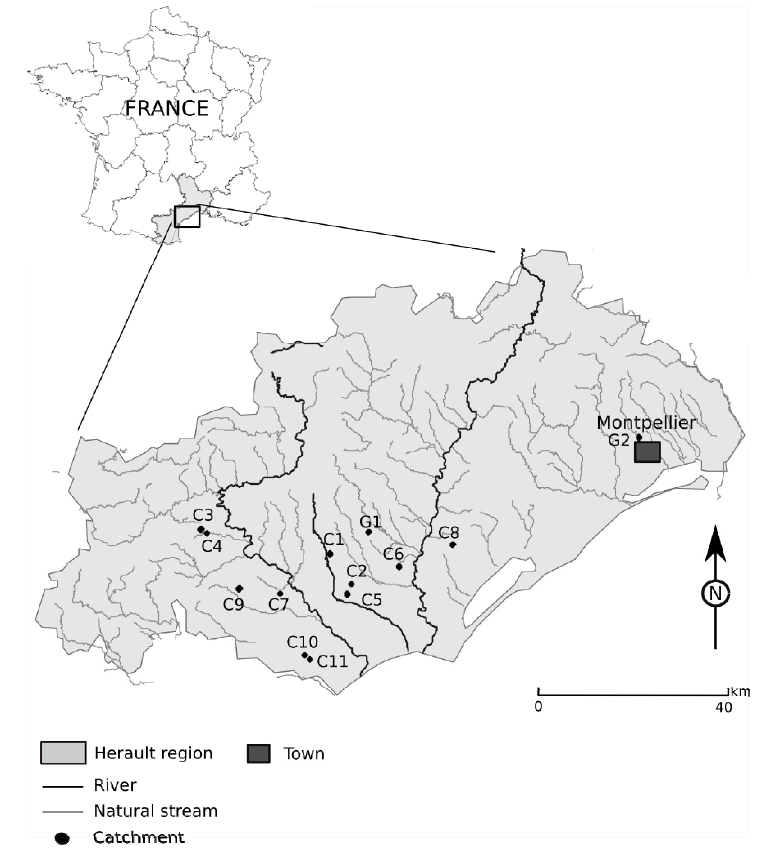
Figure 4. Catchment location.